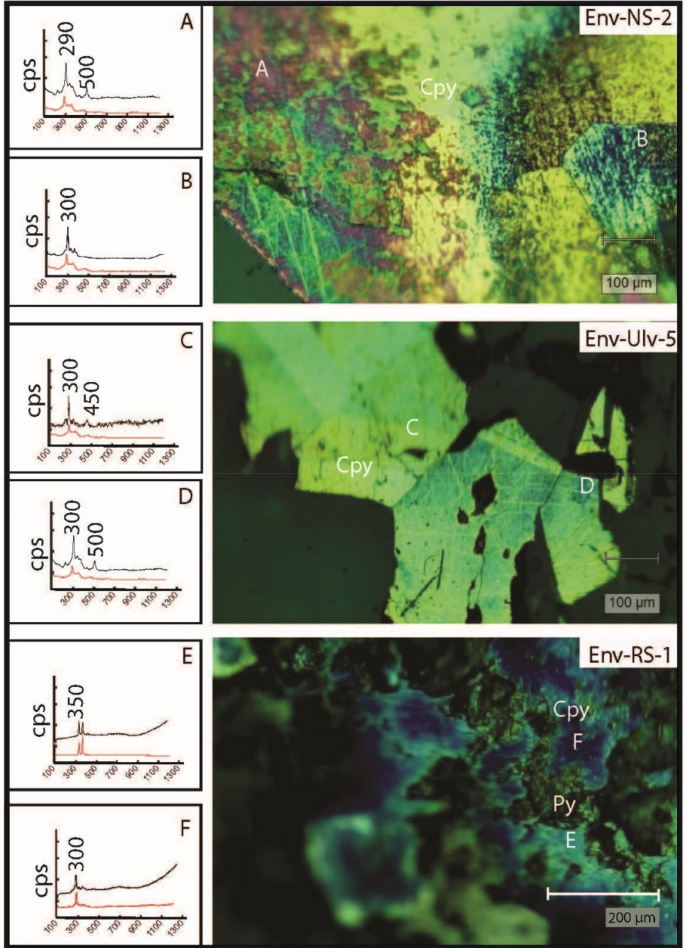
Figure 7. Raman spectrometry of chalcopyrite (Cpy) and pyrite (Py) from Nussir, Ulveryggen and Røros after 90-days of testing in selected conditions. Sample numbers correspond to condition numbers and can be found in Table 1. Cps—counts per second. A – E : right images are micropho- tographs of samples under reflected light microscope; left diagrams relate to Raman spot